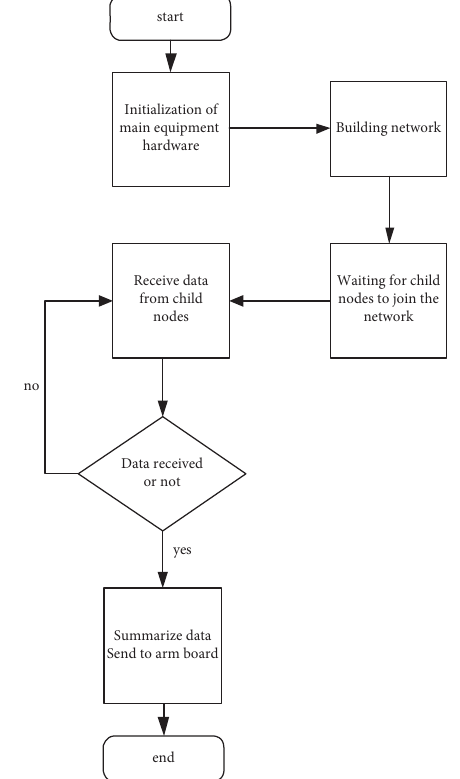
Figure 5: Transmission data flow of main equipment.